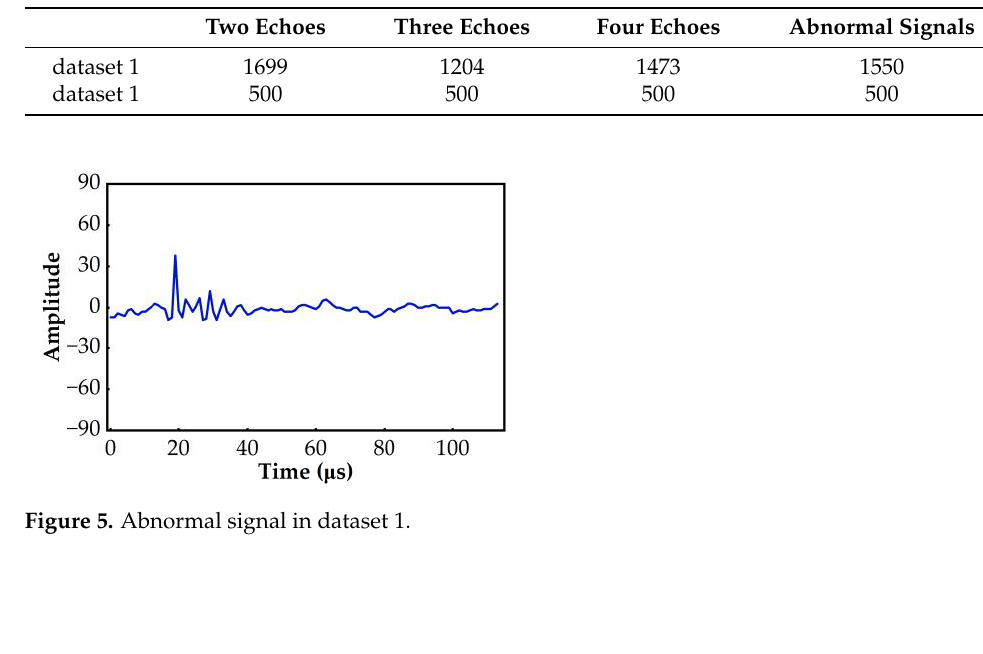
Table 2. Basic information of the pipeline.